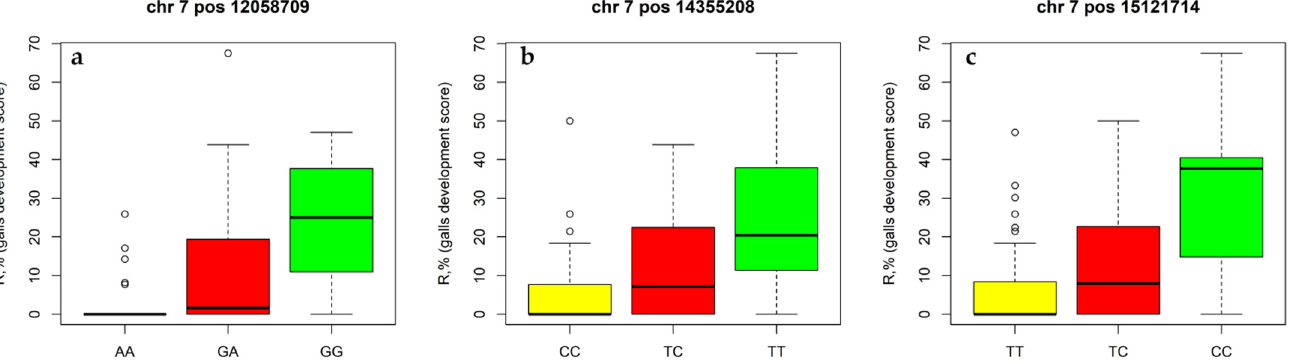
Figure 4. The box plots showing how the intensity of phylloxera gall formation (R, %, y -axis) varies depending on alleles of associated SNPs revealed on LG7. SNPs: ( a )—7_12058709 (G/A), ( b )—7_14355208 (T/C), ( c )—7_15121714 (T/C).